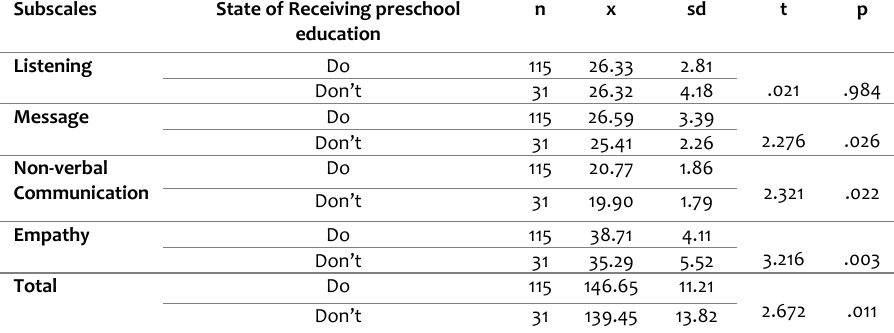
Table 1. The Parent-Child Communication Assessment Tool (PCCAT) T-Test Results regarding the Subscale Scores for Children’s Status of Receiving Preschool Education